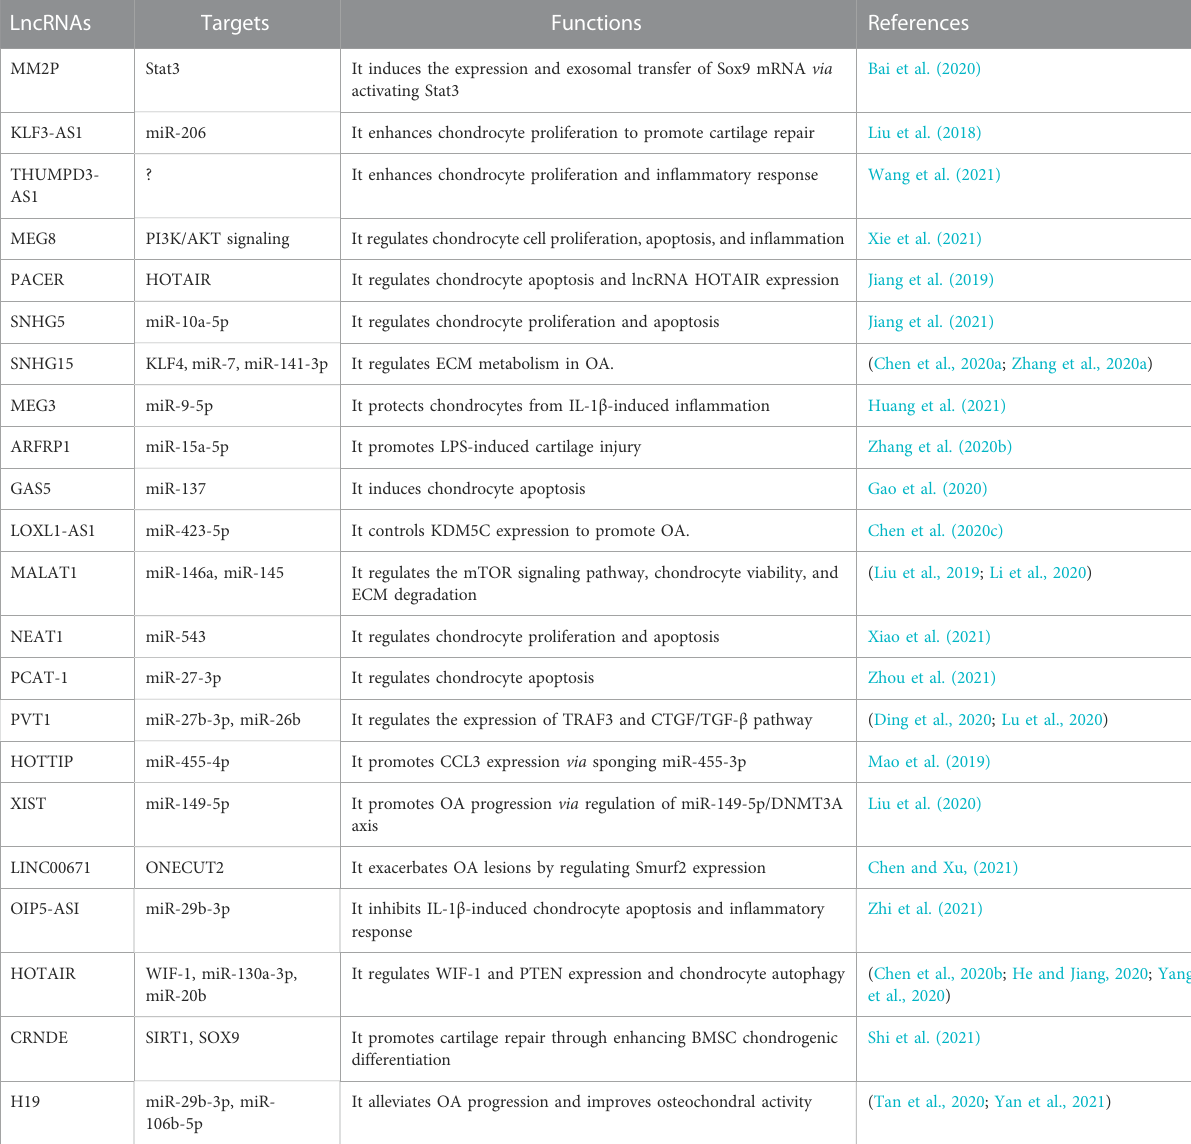
TABLE 2 Role of lncRNAs in cartilage homeostasis and OA